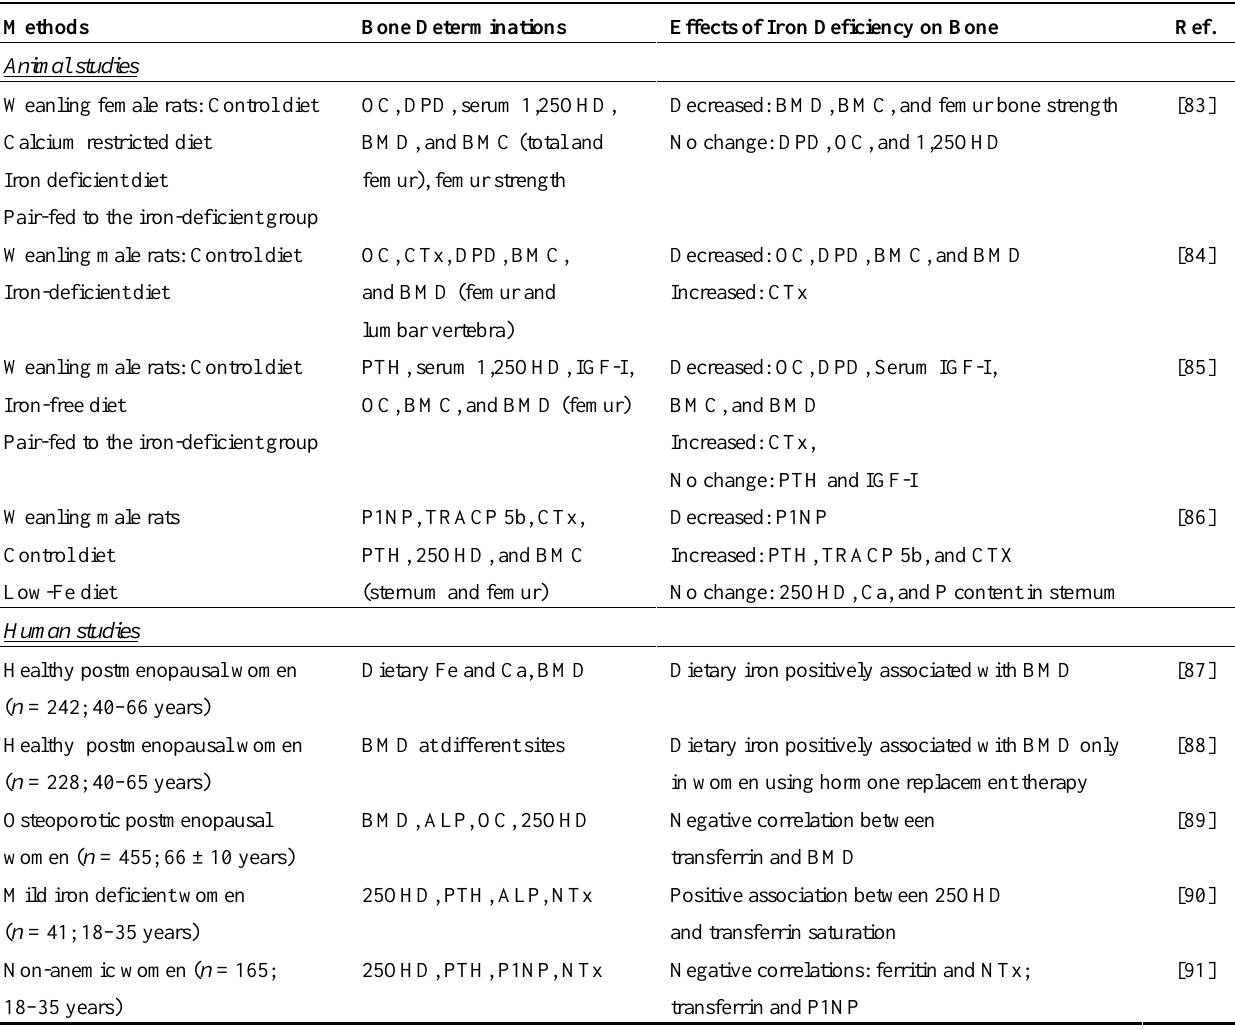
Table 4. Effects of iron deficiency on bone health in animals and